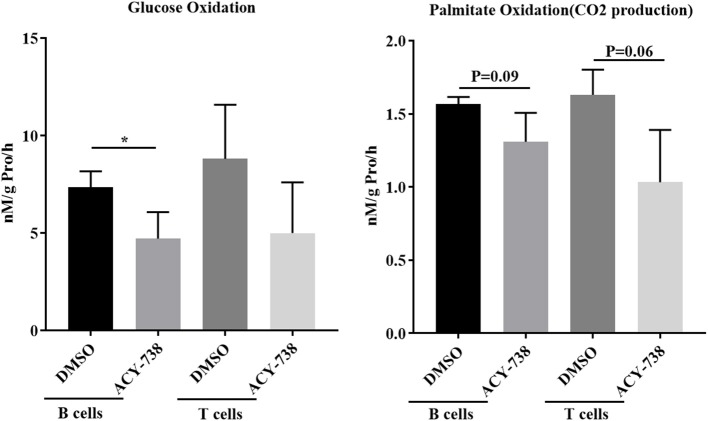
HDAC6 inhibition decreases glucose and fatty acid oxidation in T and B cells from NZB/W mice. T cells and B cells from 12-week old NZB/W female were purified and stimulated with anti CD3/CD28 or LPS, respectively, for 24 h with or without the addition of 4 uM ACY-738 (DMSO only was used as control). After 24 h of culture, CO2 production from the oxidation of glucose and palmitate were determined from three separate experiments in triplicate (n = 3). *P < 0.05.